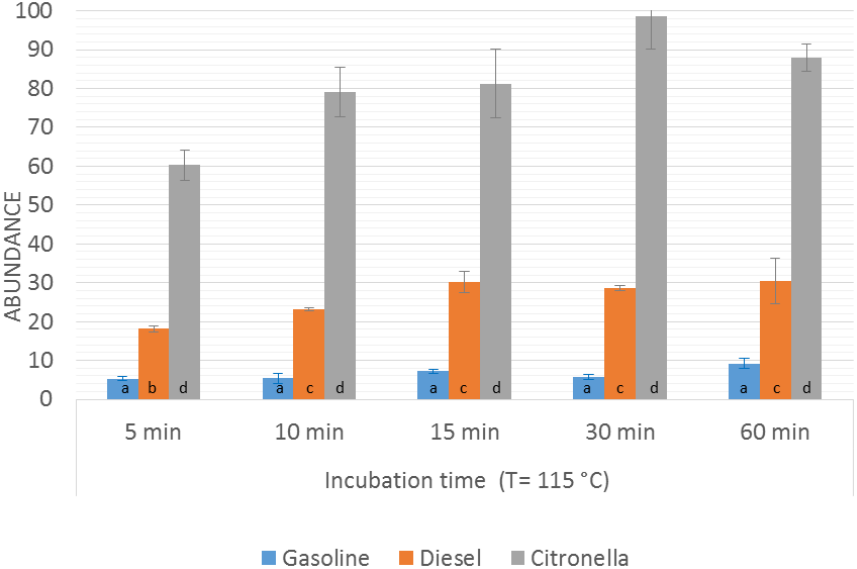
Figure 3. Sum abundance values obtained for the burned samples Gpw , Dpw , and Cpw . Incubation temperature 115 °C and different incubation times. Bars with the same letter for the same ILR indicate a non-significant difference ( p value < 0.05) according to ANOVA analysis.